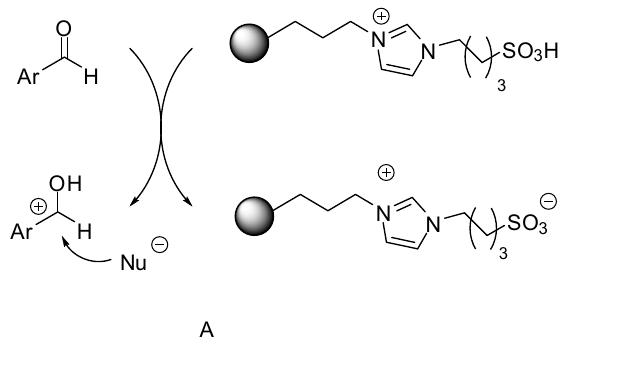
H-functionalised cation 3 − anion ( B) [56] of acidic 4